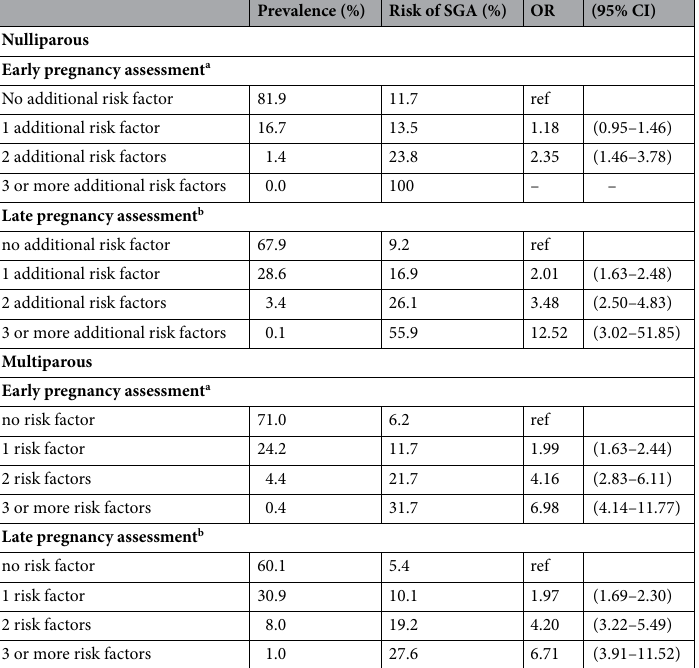
Table 3. Risk of SGA, population prevalence and composite neonatal outcomes according to a combination of risk factors. CI confidence interval, OR odds ratio, Ref reference, SGA small for gestational age. a Early pregnancy factors: underweight, lupus, smoking and previous low birthweight; b All pregnancy factors: underweight, lupus, smoking, previous low birthweight, weight gain < 5 kg and preeclampsia.